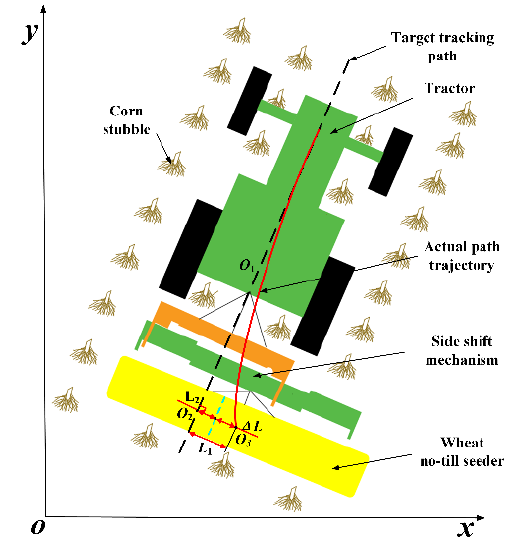
Figure 3. Schematic diagram of the kinematic model. Note: O 1 and O 2 are the target positions of the tractor and wheat no-till seeder, respectively; O 3 is the current position of the wheat no-till seeder; L 1 and L 2 are the lateral and expected deviations, respectively, mm; ∆ L is the compensation amount of lateral deviation, mm.